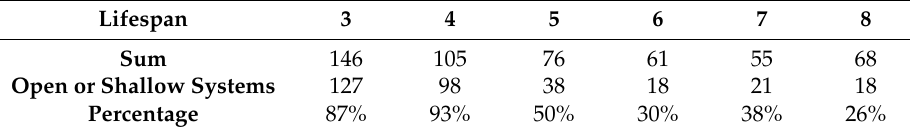
Figure 5. The frequency ( a ) and statistical key value ( b ) of the center-SLP of ICs. Table 3. The frequencies of open or shallow systems using the NCP.